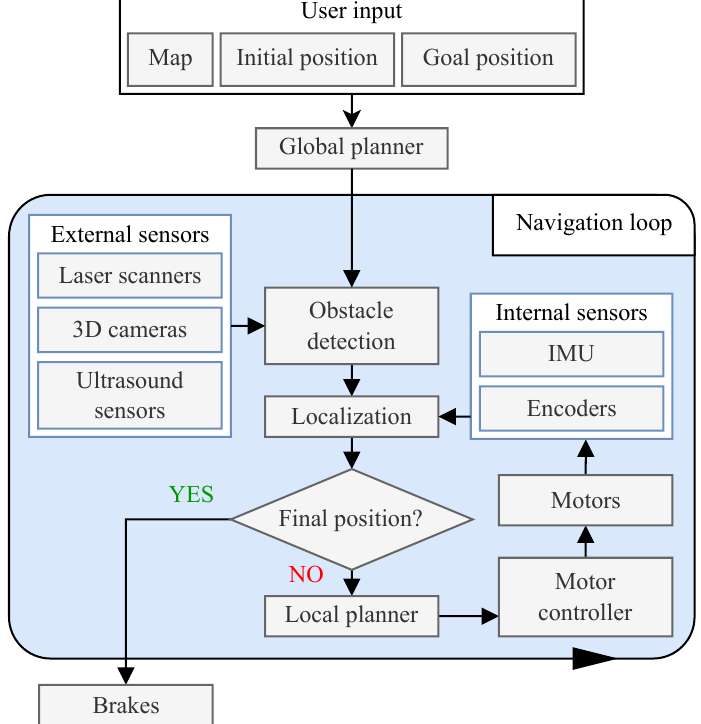
Figure 2. Navigation principle of mobile robots